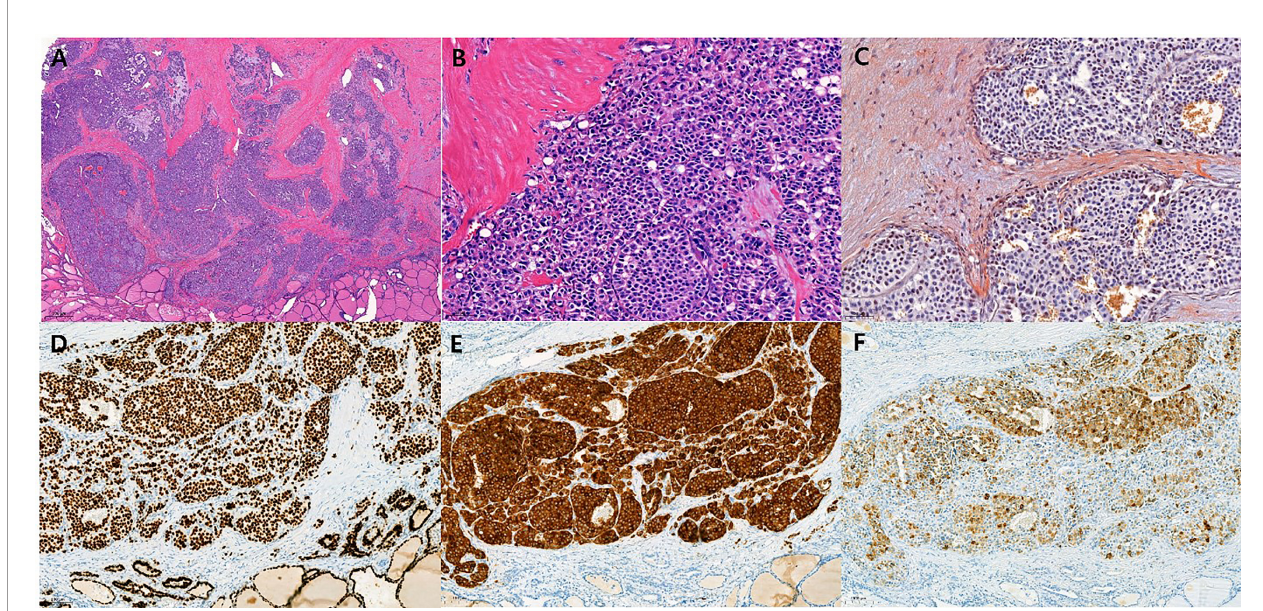
FIGURE 1 | Histopathologic fi ndings of calcitonin-negative medullary thyroid carcinoma (A) The tumor shows solid sheets and nests growth patterns with fi broticstroma. (H&E, ×20) (B) The polygonal tumorcells contain round to oval nuclei with coarse chromatin.Nucleoliare not prominent and the cytoplasm is granular andeosinophilic. (H&E, ×200) (C) The amyloid deposition in stroma isrecognized byCongo redstain with polarized microscopicexamination (Congo red,×200).The tumor cells show strongand diffuse immunoreactivity for TTF-1 [ (D) , ×100] and synaptophysin [ (E) , ×100], andshow weak to strong heterogeneous immunoreactivity for calcitonin [ (F) ,